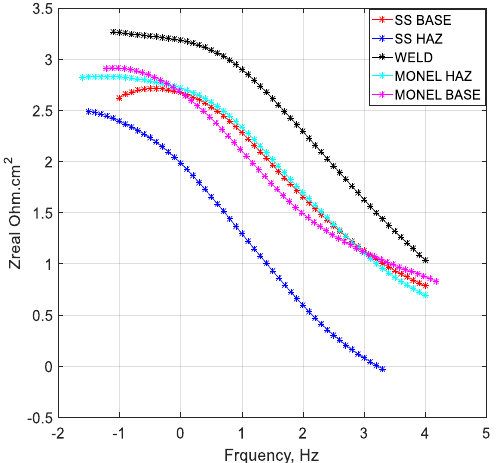
Figure 14. Bode plot for CT specimen.